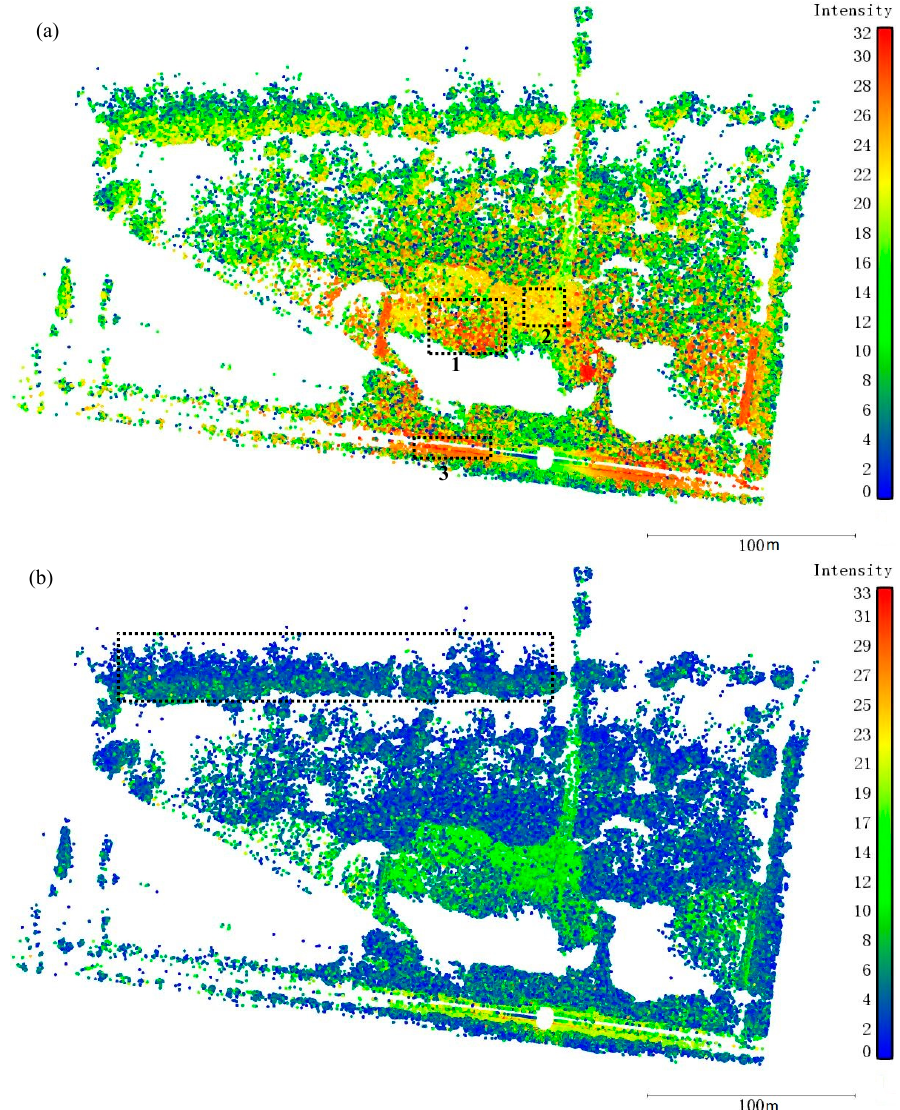
Figure 7. Point cloud colored by intensity. ( a ) Original intensity data. ( b ) Final corrected intensity by the improved method. The total number of points is 931,381. The white parts among the figures have no measured points considering water accumulation or occlusion.